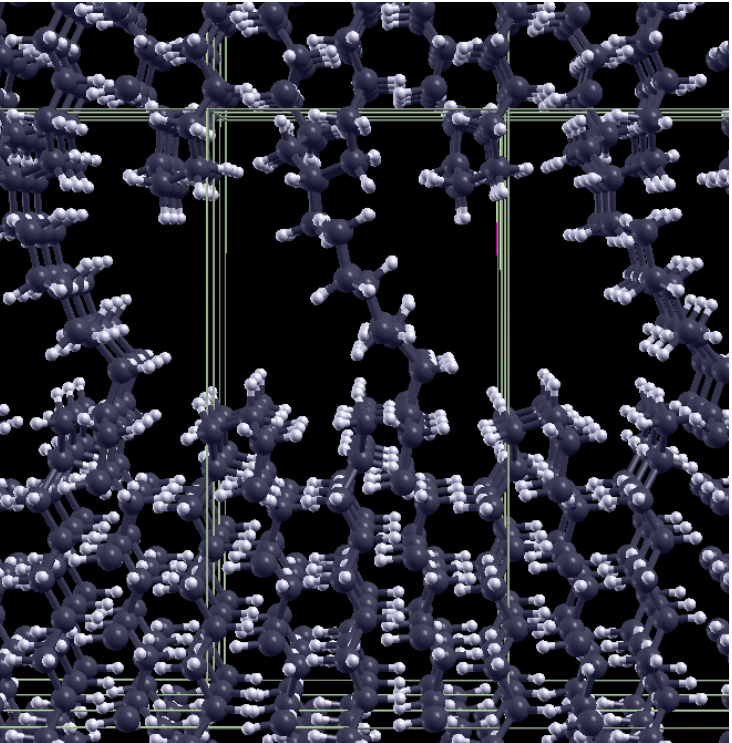
Figure 1. The PE model used for DFT calculations; the periodically repeated unit cell, including a thin crystalline lamella with two surfaces connected by an alkyl chain, is shown. The parameters of the orthorhombic cell, containing 151 atoms, are 9.72, 6.96, and 19.96 Å.